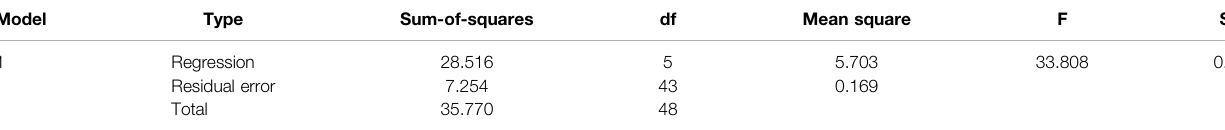
TABLE 5 | Parameters of the multivariate analysis of variance.